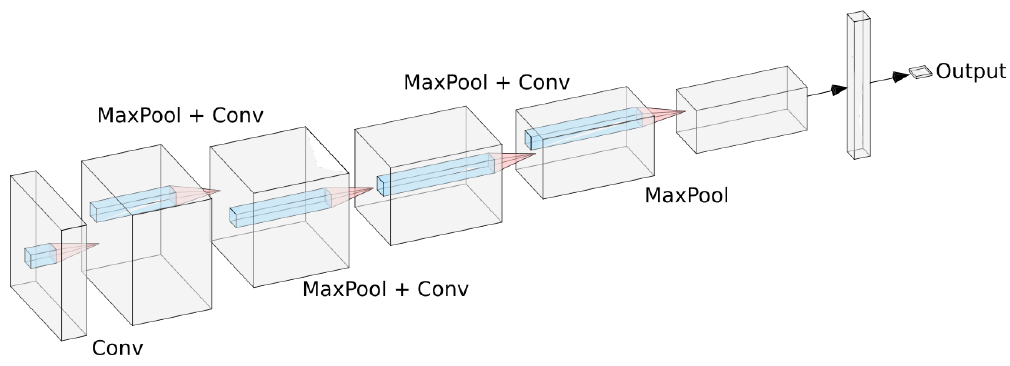
Figure 2. Proposed CNN architecture as described in